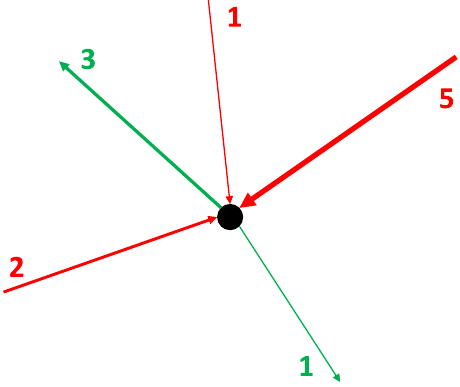
FIG. 2. An isolated node with three inward links and two outward links. This node has in-strength s i ¼ 8 , out-strength s ¼ 4 , and net-strength s ¼ 4 o n